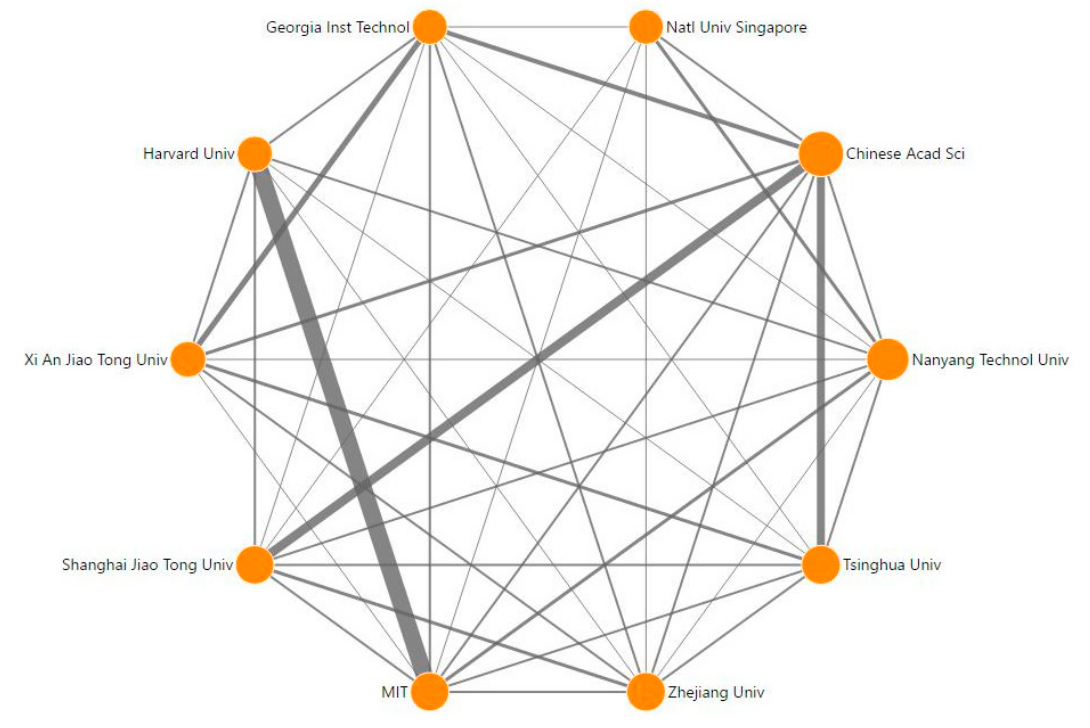
Figure 5. The collaboration matrix map among the top 10 Most Productive Institutions.